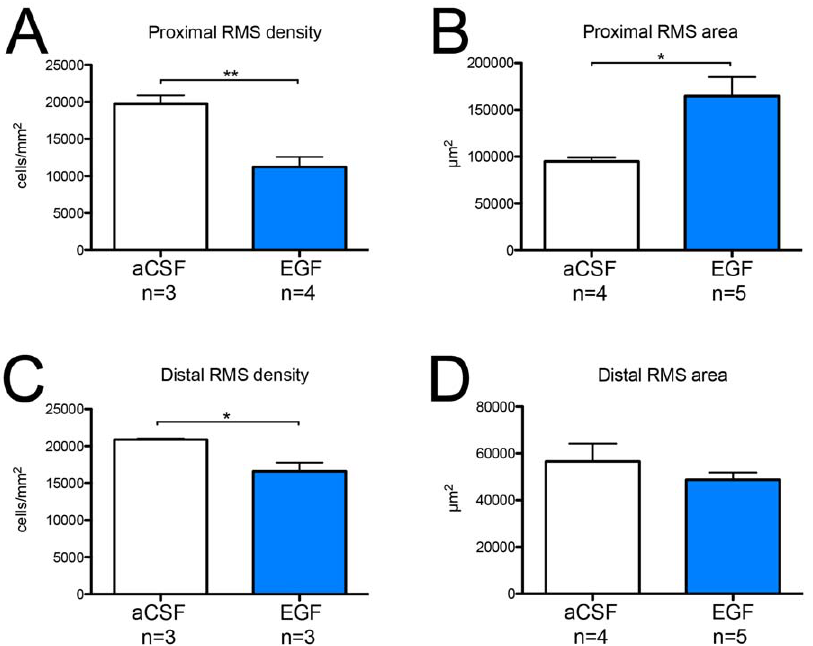
Figure 1. Cell density and size of the rostral migratory stream after EGF infusion. To assess EGF-induced structural changes in the rostral migratory stream (RMS) cell density and cross-sectional area were quantified at a proximal and a distal position relative to the SVZ. ( A, C ) Cell density was determined by counting cell nuclei and expressed as the number of cells per mm 2 6 SEM. ( B, D ) The size of the RMS was determined by tracing the border of the RMS on coronal sections. Data are presented as average cross-sectional area per section expressed in mm 2 6 SEM. For both analyses 1–4 coronal sections per animal were used. Statistical significance was assumed at * p , 0.05 and ** p , 0.01 using Student’s t-test.